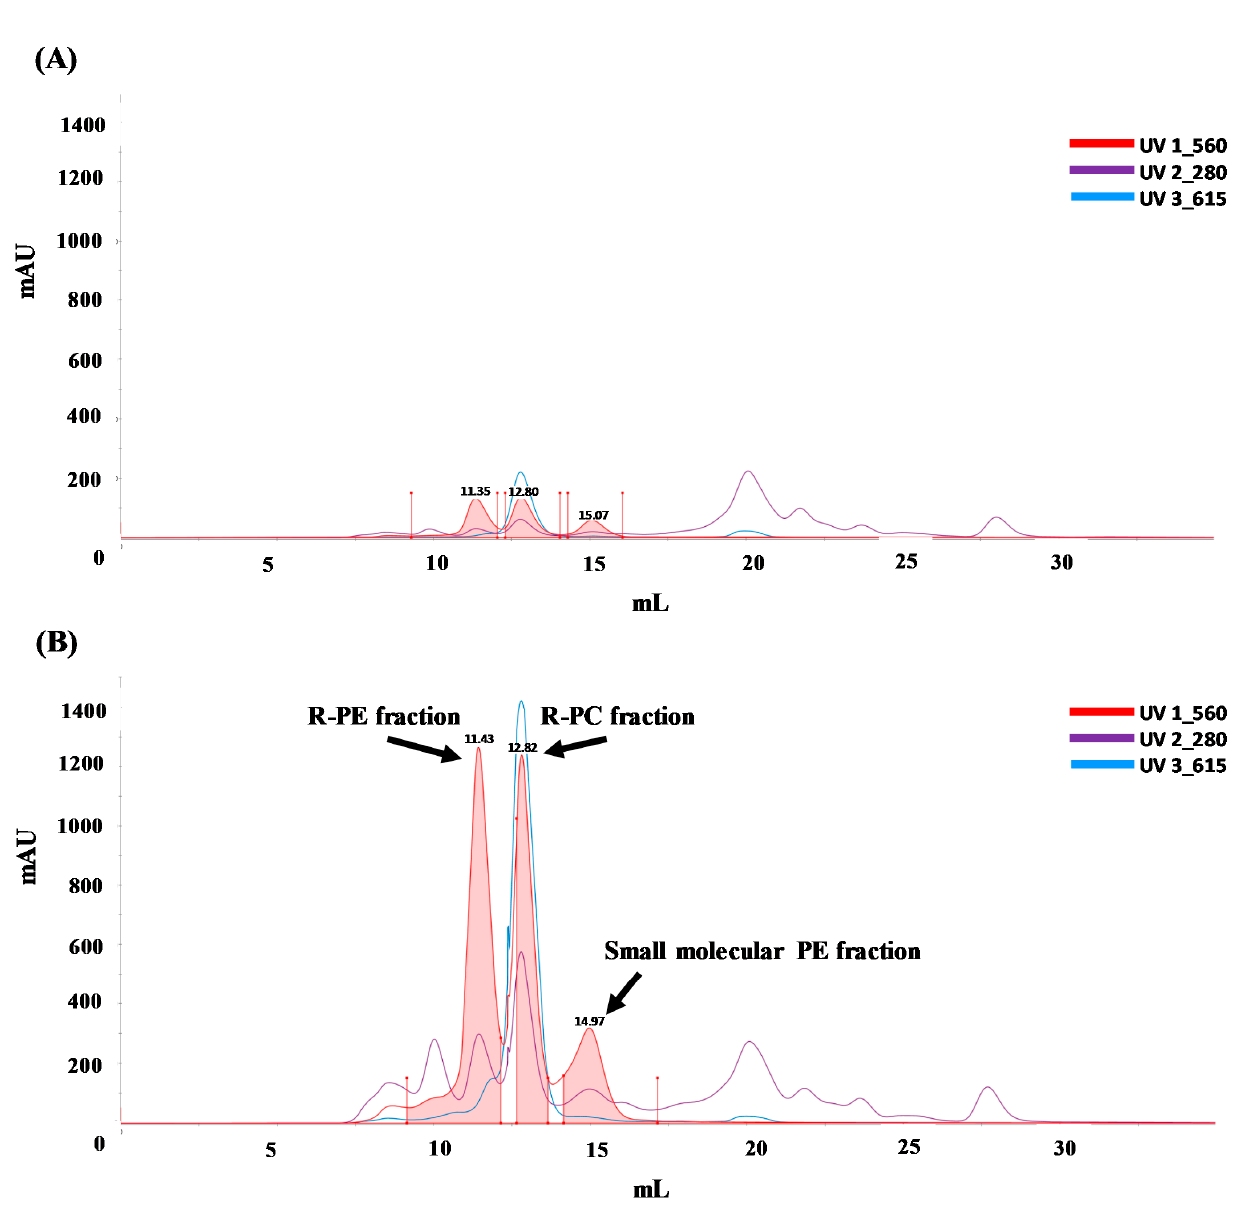
Figure 3. FPLC chromatograms of ( A ) unpurified and ( B ) purified Porphyra PorPBE extract by ultrafiltration. Table 3. FPLC analysis of R-PE, R-PC and small molecule PE fractions.